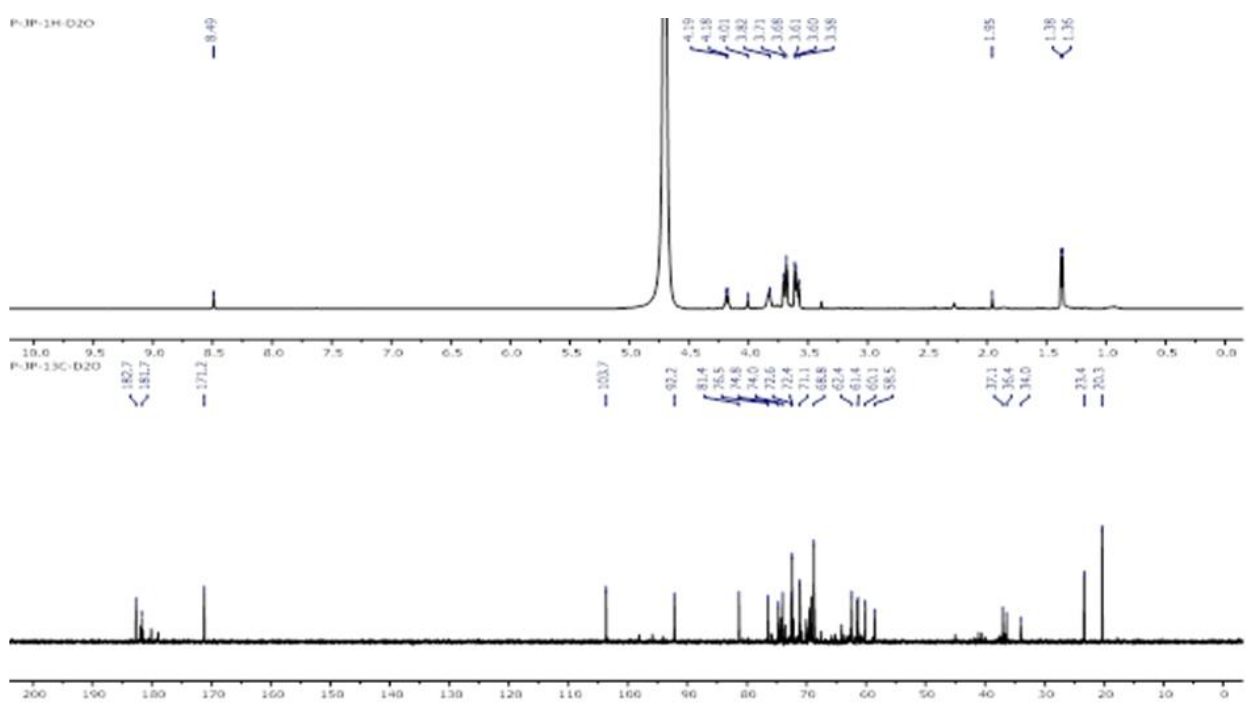
Figure 3. 1 H (D 2 O, 500 MHz) and 13 C NMR spectra (D 2 O, 125 MHz) of P-JP.